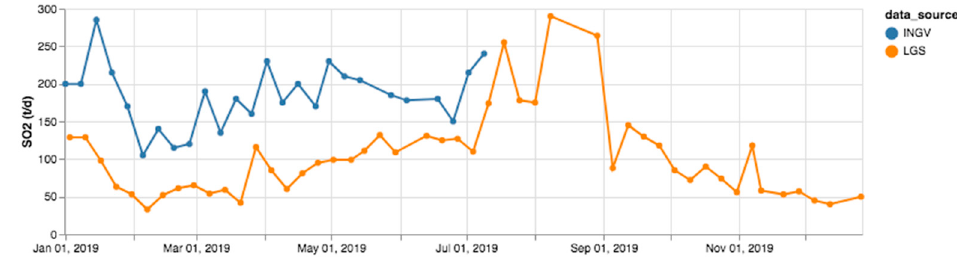
Figure 11. Comparison of SO 2 flux measurements reported in INGV and LGS weekly bulletins during 2019.